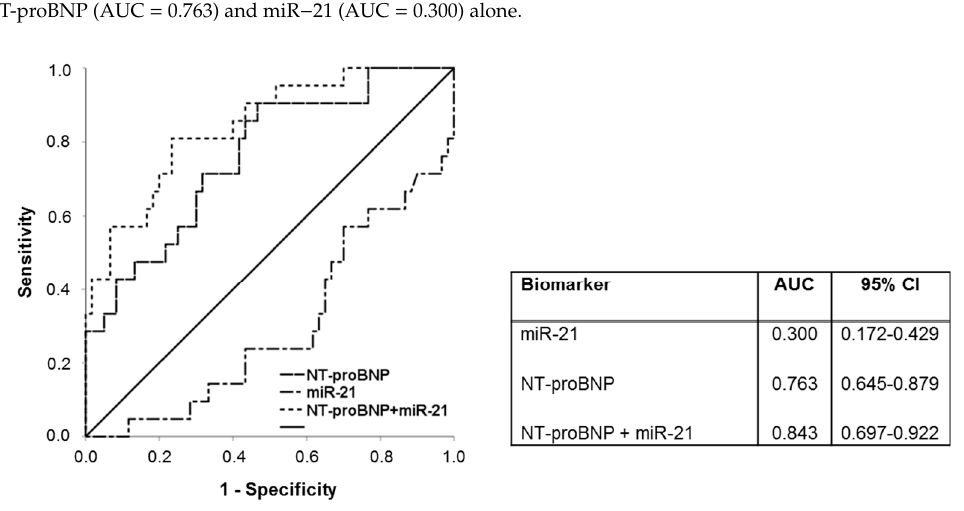
ST2 — suppression of tumorigenicity 2. Receiver operating characteristic (ROC) curve analysis presenting the predictive ability of miR − 21, NT-proBNP and the combination of NT-proBNP and miR − 21, are presented in Figure 5. Of note, the AUC is clearly enhanced by addition of miR − 21 to NT-proBNP (AUC = 0.843) in comparison to NT-proBNP (AUC = 0.763) and miR − 21 (AUC = 0.300) alone.